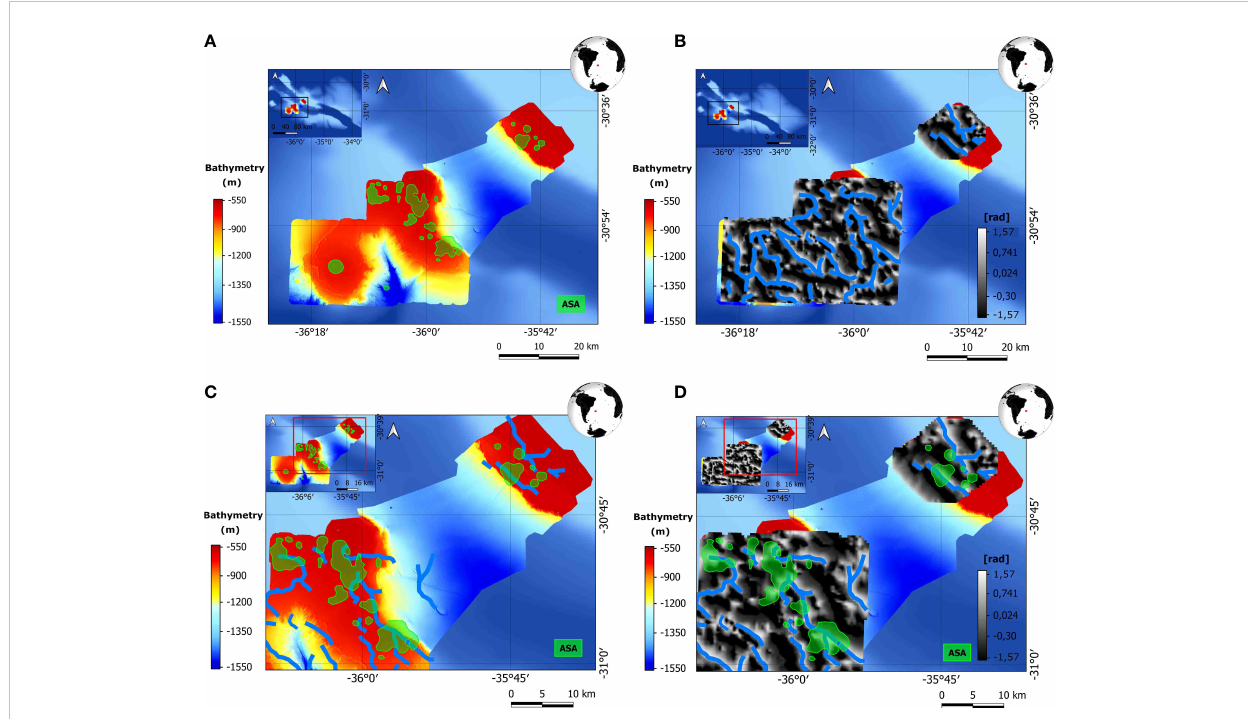
FIGURE 10 Maps with the Analytic Signal Amplitude (ASA) and Tilt Derivative (TDR) results in the study area. (A) shows the bathymetric map with the main anomalies found by the ASA fi lter application (in green). (B) shows the TDR fi lter result in the study area applied over the Reduction to Pole result in both areas (A1 and A2). (C) is a zoom of the bathymetric map indicating the lineaments at the rift margin (in blue) and possible ASA anomalies (in green) that could be associated with it. (D) is a zoom of the TDR map showing the lineaments in the rift margin (in blue) and possible anomalies ASA associated with it (in